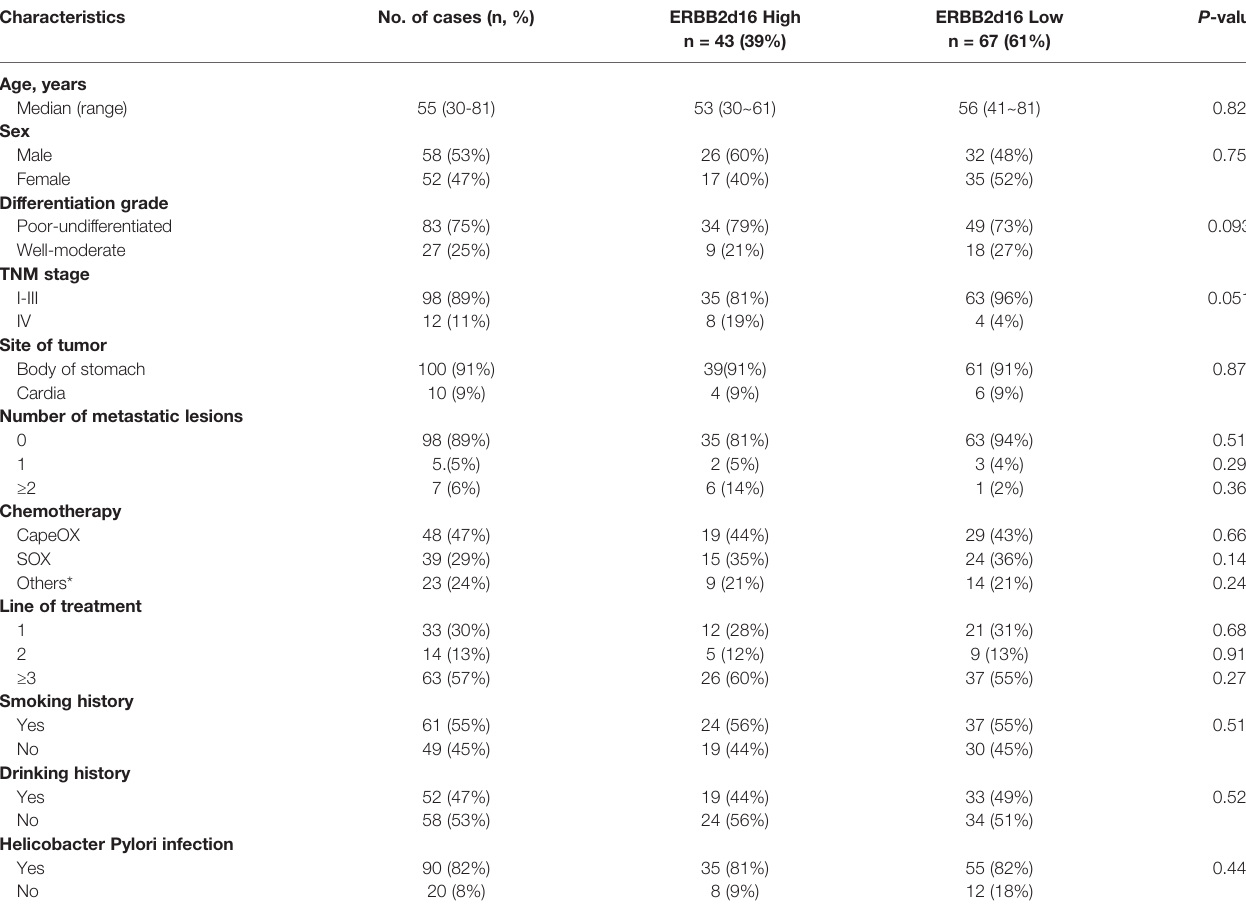
TABLE 1 | Patient and tumor characteristics (N =